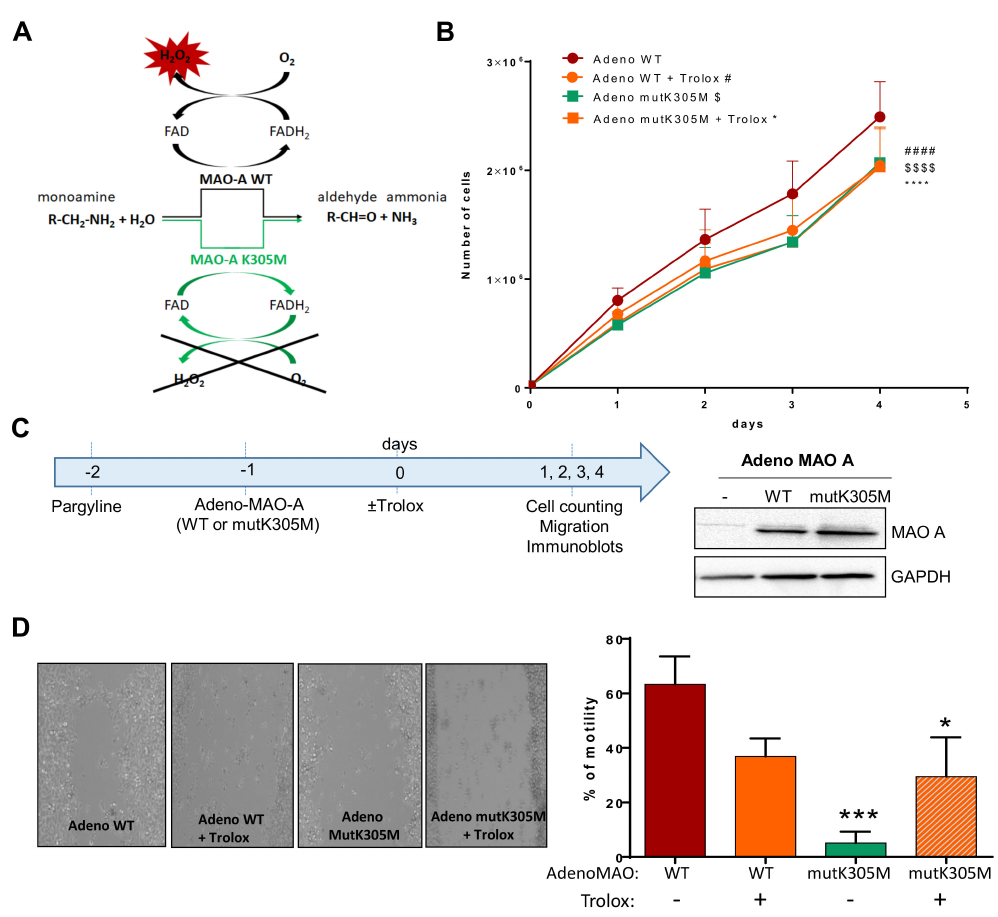
Figure 5. Effects of WT or K305M MAO-A in AY27 tumorigenesis. ( A ) MAO-A K305M mutant construct is unable to use O 2 as an electron acceptor for reoxidation of the enzyme, preventing the formation of H 2 O 2 . An alternative electron acceptor is used to recycle the mutant enzyme, which is still able to degrade amine substrates (Iacovino et al., 2020). ( B ) Proliferation curve of AY27 cells after adeno WT or adeno mutK305M transductions. Cells were treated or not with Trolox and counted each day until 96 h (N = 4). ( C ) After pretreatment with pargyline to block endogenous MAO mutant K305M (mutK305M) forms of MAO-A. Western blot analyses were performed at 72 h